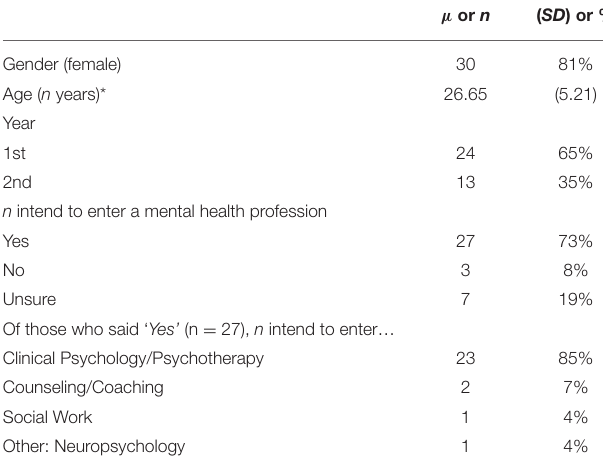
TABLE 2 | Sample characteristics ( n =